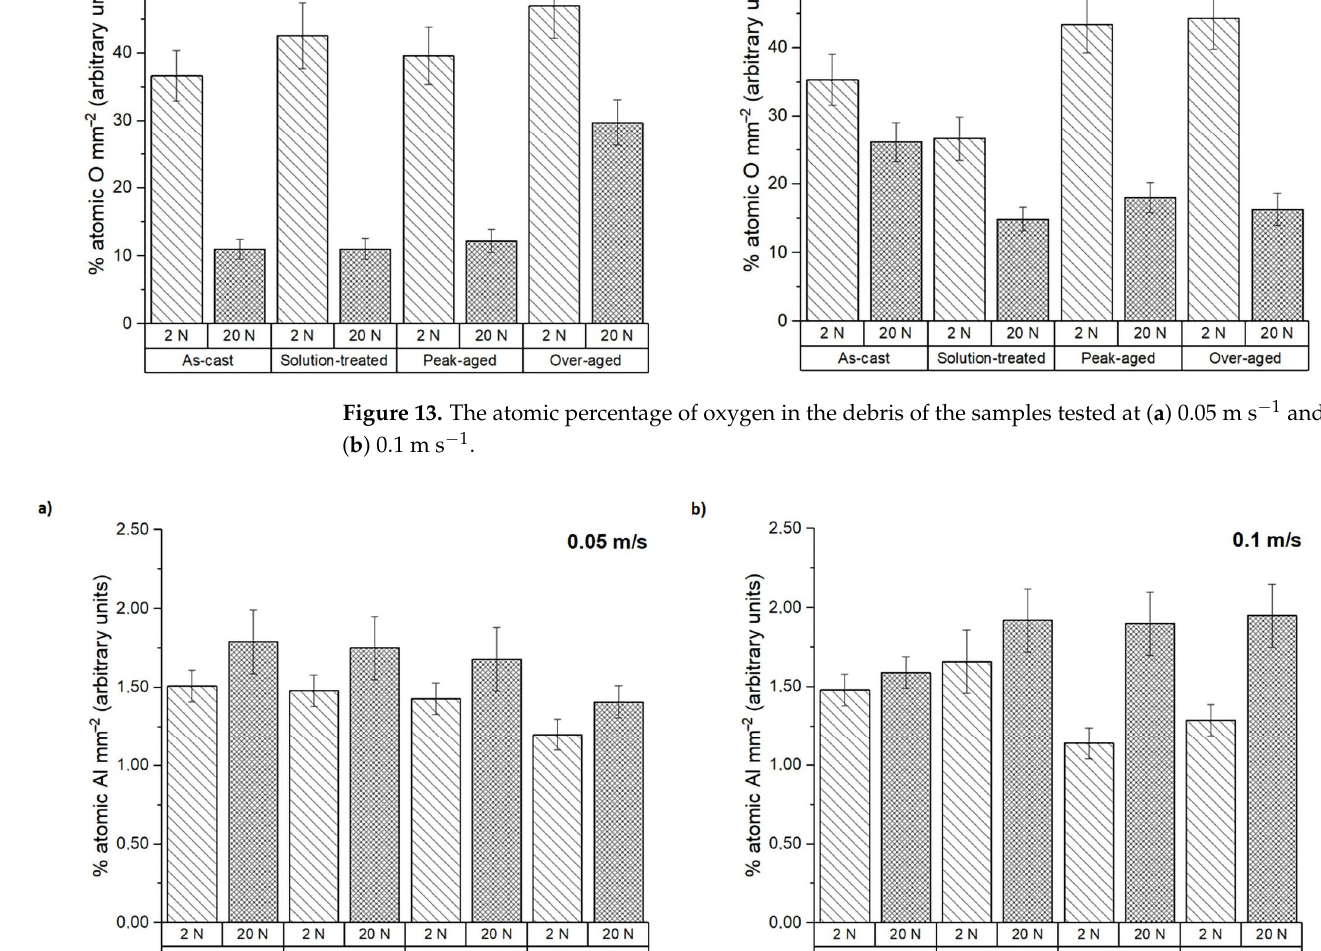
Figure 14. The atomic percentage of aluminum in the debris at sliding speeds of ( a ) 0.05 m s − 1 and ( b ) 0.1 m s − 1 .